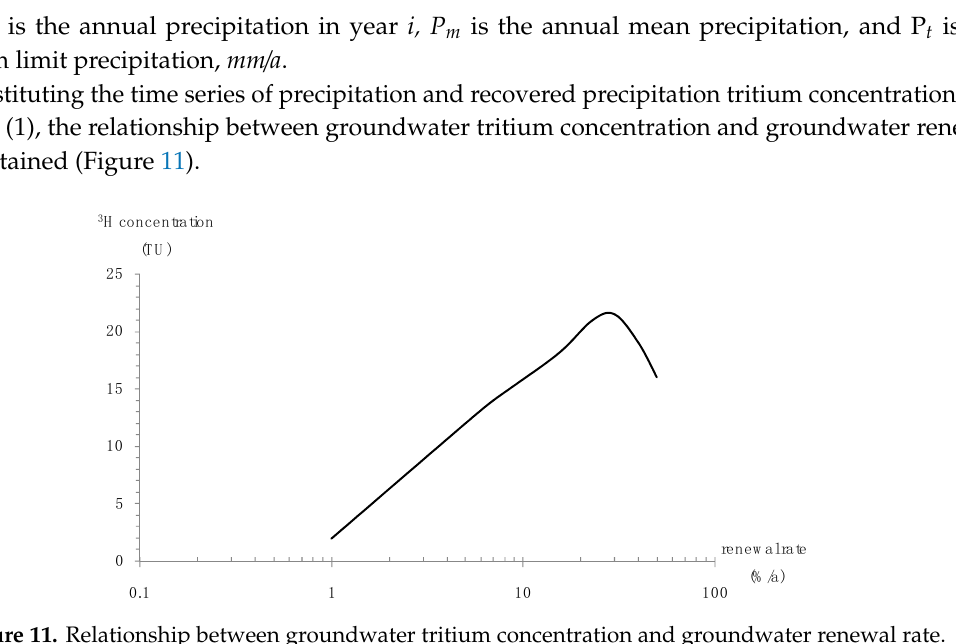
Table 4. Ratios of NO − stored and downstream groundwater (%).